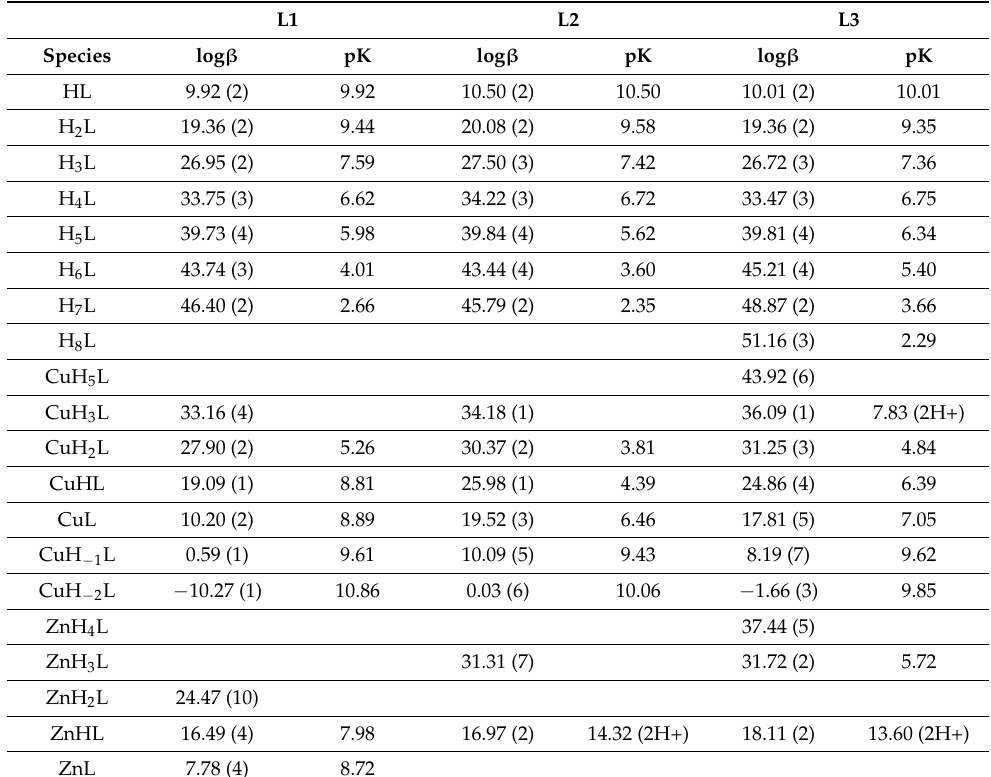
Table 2. Potentiometric data for the proton, M(II) (Cu(II) and Zn(II)) KSAFELPHYGLLAHQ (L1), KSHFELPAYGLLAHQ (L2), and KSHFELPHYGLLAHQ (L3). M(II) to peptide molar ratio, 1:1.1, T:298 K, I = 0.1 M, [M(II)] = [L1–3] = 0.0005